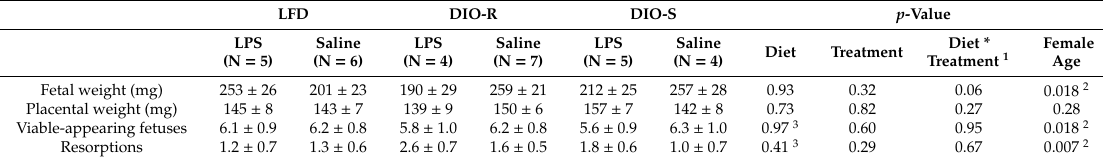
Table 5. Reproductive traits in females fed a high-fat diet (HFD) or low-fat diet (LFD) for 13 weeks prior to mating, injected with LPS or saline on gestational day 7 and found to be pregnant at gestational day 14. Females that weighed more or less at first mating than the mean of LFD mice plus 3 SD were considered susceptible or resistant to diet-induced obesity (DIO-S or DIO-R), respectively. LFD DIO-R DIO-S p -Value LPS Saline LPS Saline LPS Saline Diet * Female (N = 5) (N = 6) (N = 4) (N = 7) (N = 5) (N = 4) Diet Treatment Treatment 1 Age Fetal weight (mg) 253 ± 26 201 ± 23 190 ± 29 259 ± 21 212 ± 25 257 ± 28 0.93 0.32 0.06 0.018 2 Placental weight (mg) 145 ± 8 143 ± 7 139 ± 9 150 ± 6 157 ± 7 142 ± 8 0.73 0.82 0.27 0.28 Viable-appearing fetuses 6.1 ± 0.9 6.2 ± 0.8 5.8 ± 1.0 6.2 ± 0.8 5.6 ± 0.9 6.3 ± 1.0 0.97 3 0.60 0.95 0.018 2 Resorptions 1.2 ± 0.7 1.3 ± 0.6 2.6 ± 0.7 1.6 ± 0.5 1.8 ± 0.6 1.0 ± 0.7 0.41 3 0.29 0.67 0.007 2 * the standard notation for a statistical interaction. 1 The statistical interaction between diet and treatment (LPS vs. saline). 2 For fetal weight and number of viable-appearing fetuses, the relationship with female age was negative, while for number of resorptions, it was positive. 3 E ff ects were not significant when testing diet separately with nonparametric Kruskal–Wallis